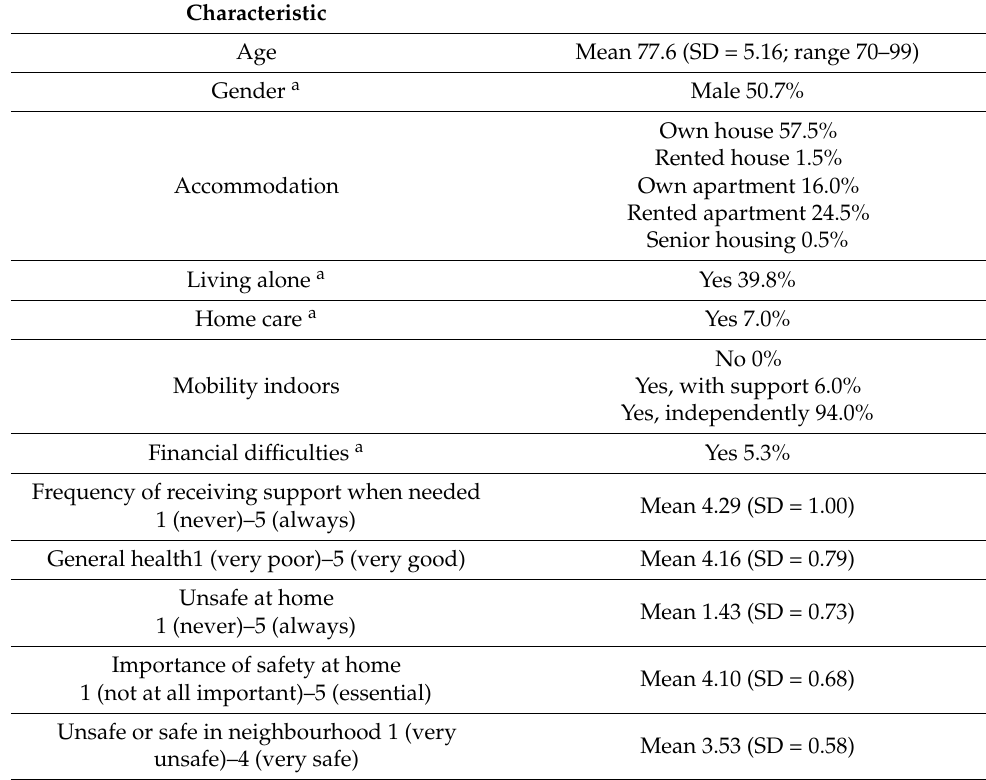
Table 1. Participants’ background characteristics, n =